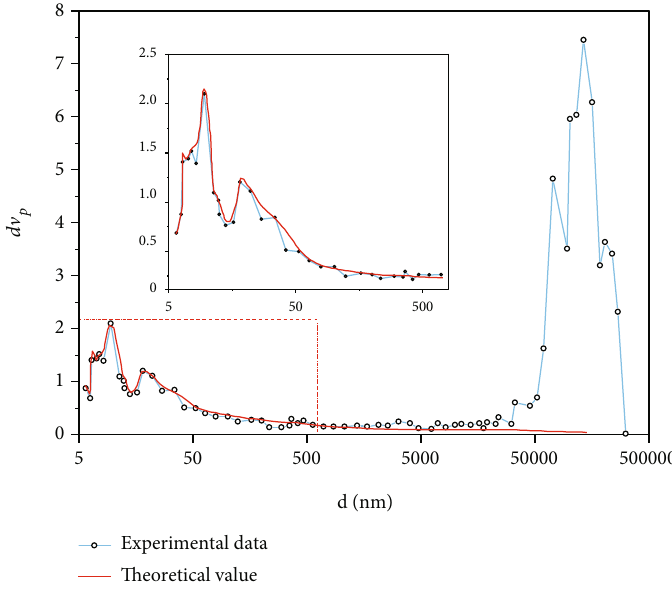
Figure 6: Relation between pore volume dV